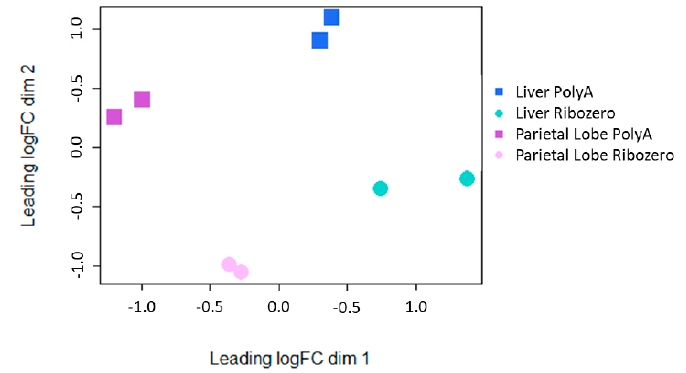
Figure 3. Multidimensional scaling plot of the lncRNA expression from each tissue/library preparation for each horse.